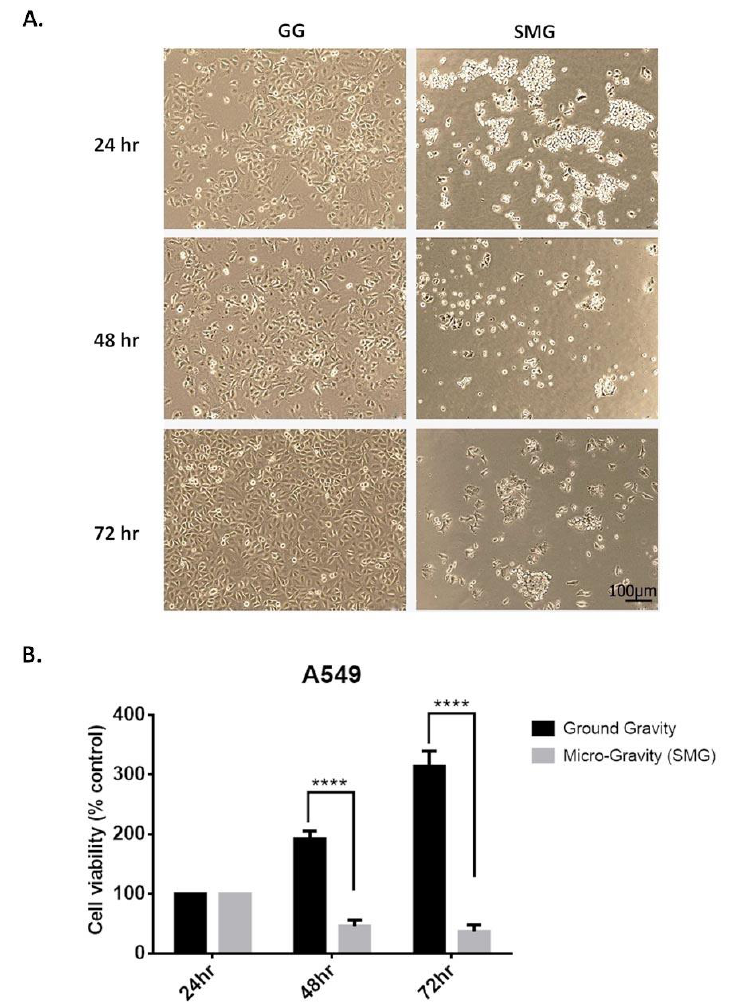
Figure 5. Simulated microgravity reduces cell viability and induces morphological changes of A549 cells in a time-dependent manner. ( A ) Representative micrographs of parental A549 cells (GG) and A549 cells subjected to SMG for 24, 48, and 72 h prior to seeding them back for 1hr under GG. Images were taken at 10X magnification. ( B ) Cell viability of A549 cells was assessed using trypan blue dye exclusion assay. Average cell viability of 3 independent experiments is displayed as percentage control. **** p < 0.0001.